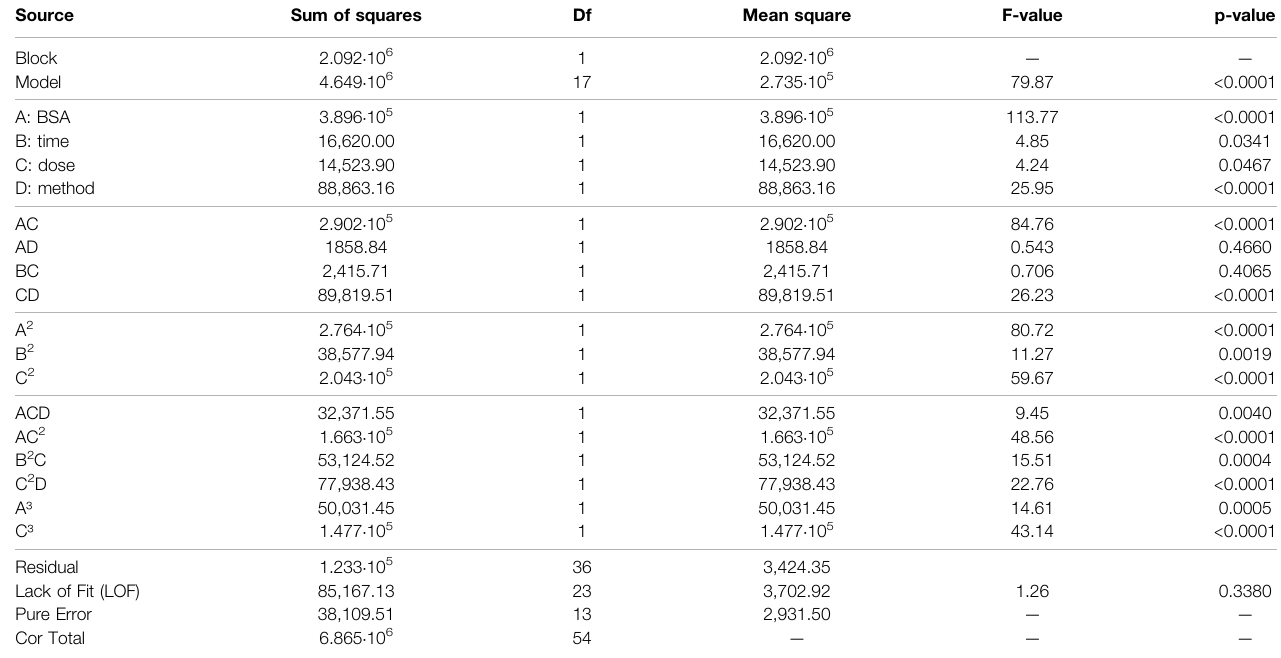
TABLE 5 | ANOVA results for response R1, BSA grafting yield (RSM, I-optimal design). Source Sum of